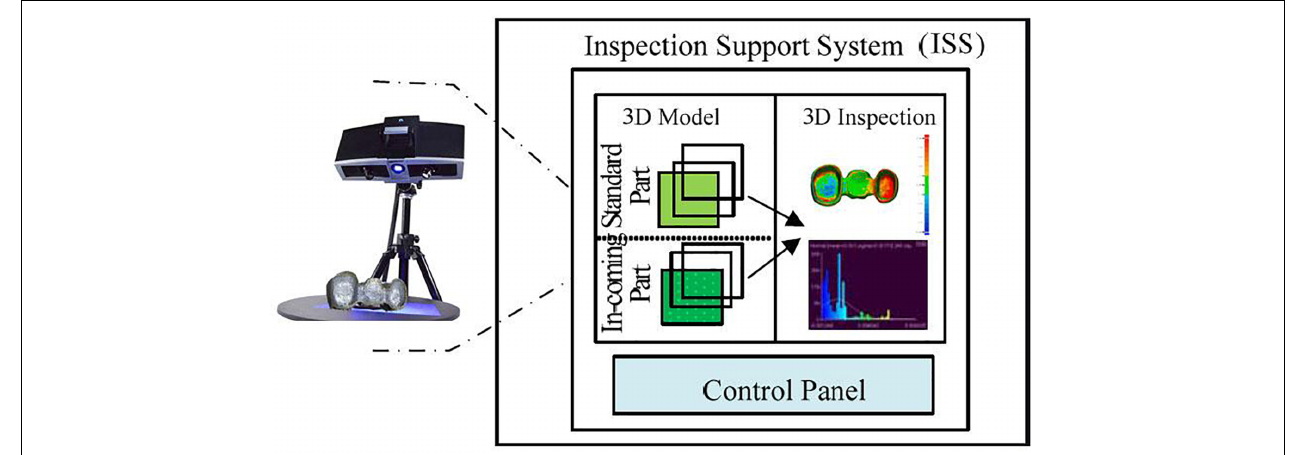
FIGURE 1 | The framework of the 3D E-quality control